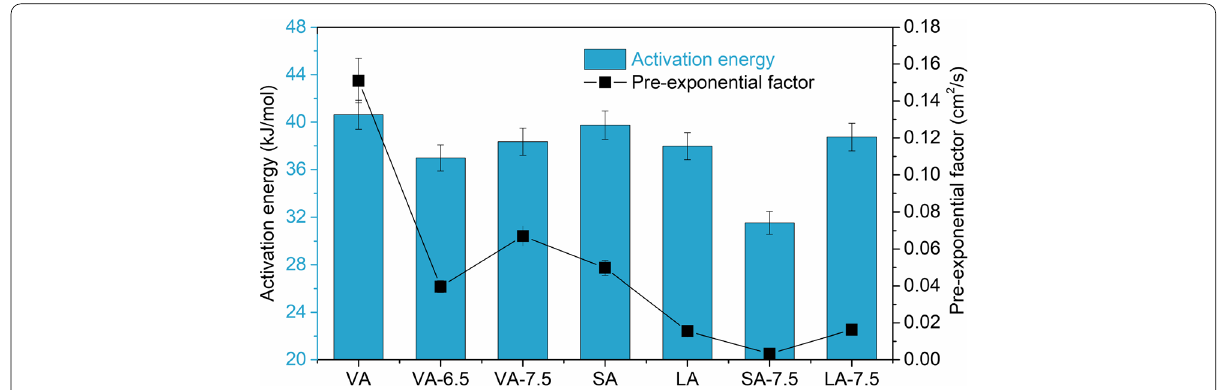
Fig. 21 Activation Energy and Pre-Exponential Factor of the Asphalt Models